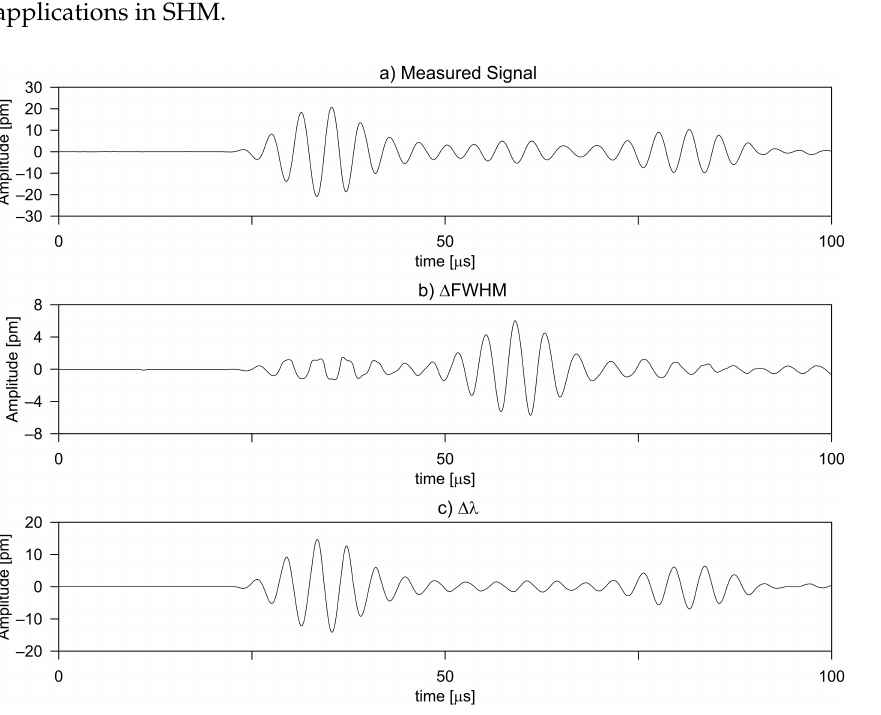
Figure 22. Comparison of time signals for the raw data and the modulation in FWHM and λ B for 250 kHz